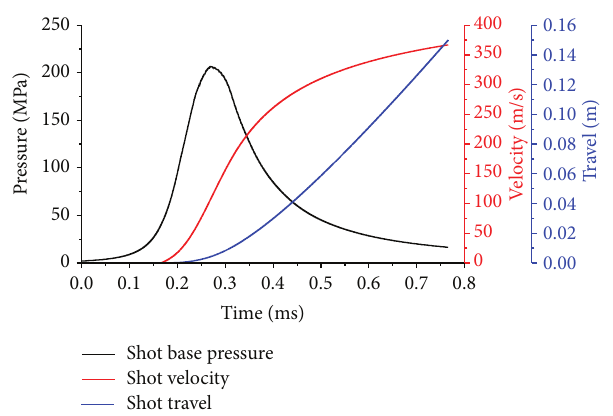
Figure 5: Time history of shot base pressure, shot velocity, and shot travel for 𝑚 𝑝 = 0.245 g, without barrel friction.